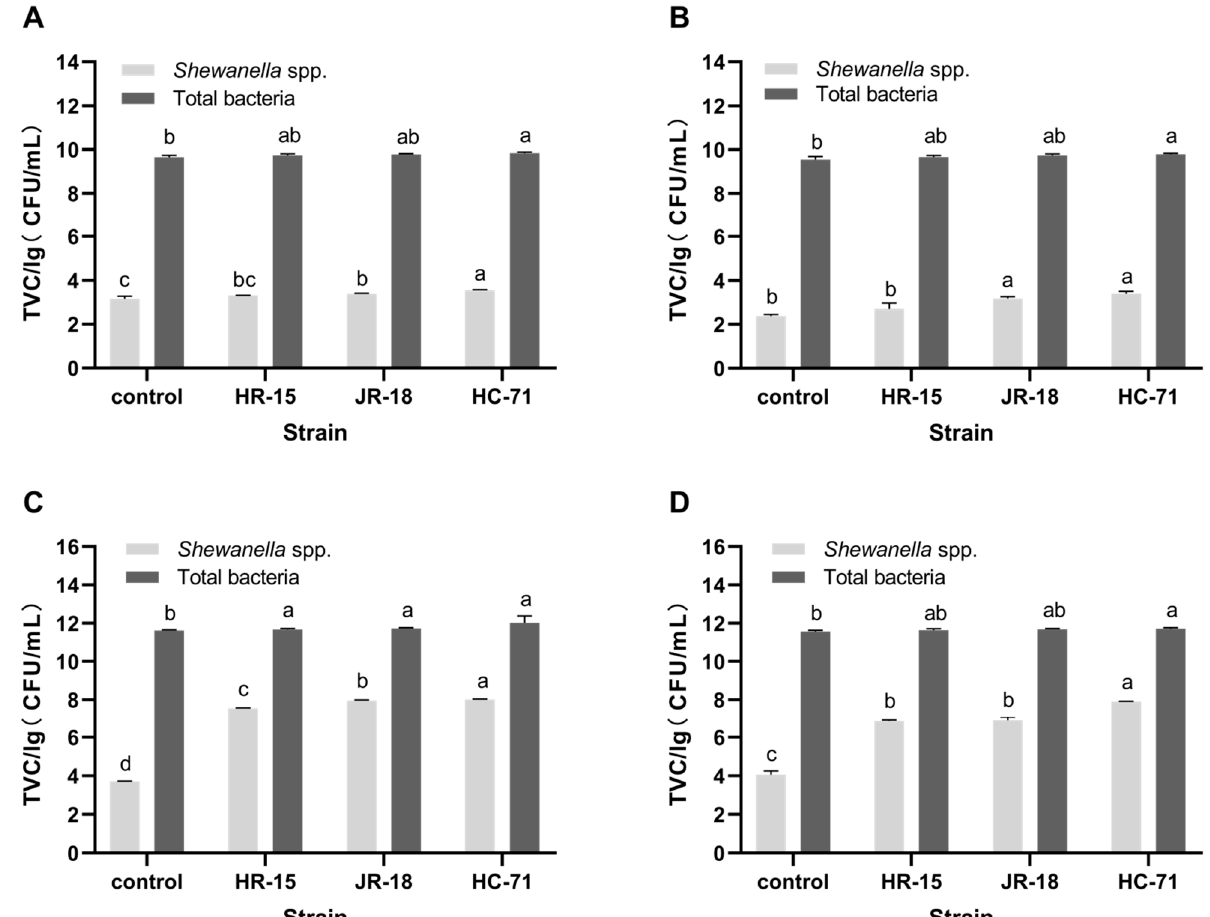
Figure 3. The qPCR analysis of the bacterial growth in the intestine and flesh of tilapia during storage at 4 ◦ C. Shewanella spp. and total bacteria content in the intestine ( A ) and flesh ( B ) after 0 days of refrigeration; Shewanella spp. and total bacteria content in the intestine ( C ) and flesh ( D ) after 6 days of refrigeration. Different lowercase letters indicate significant differences at the 0.05 level ( p <